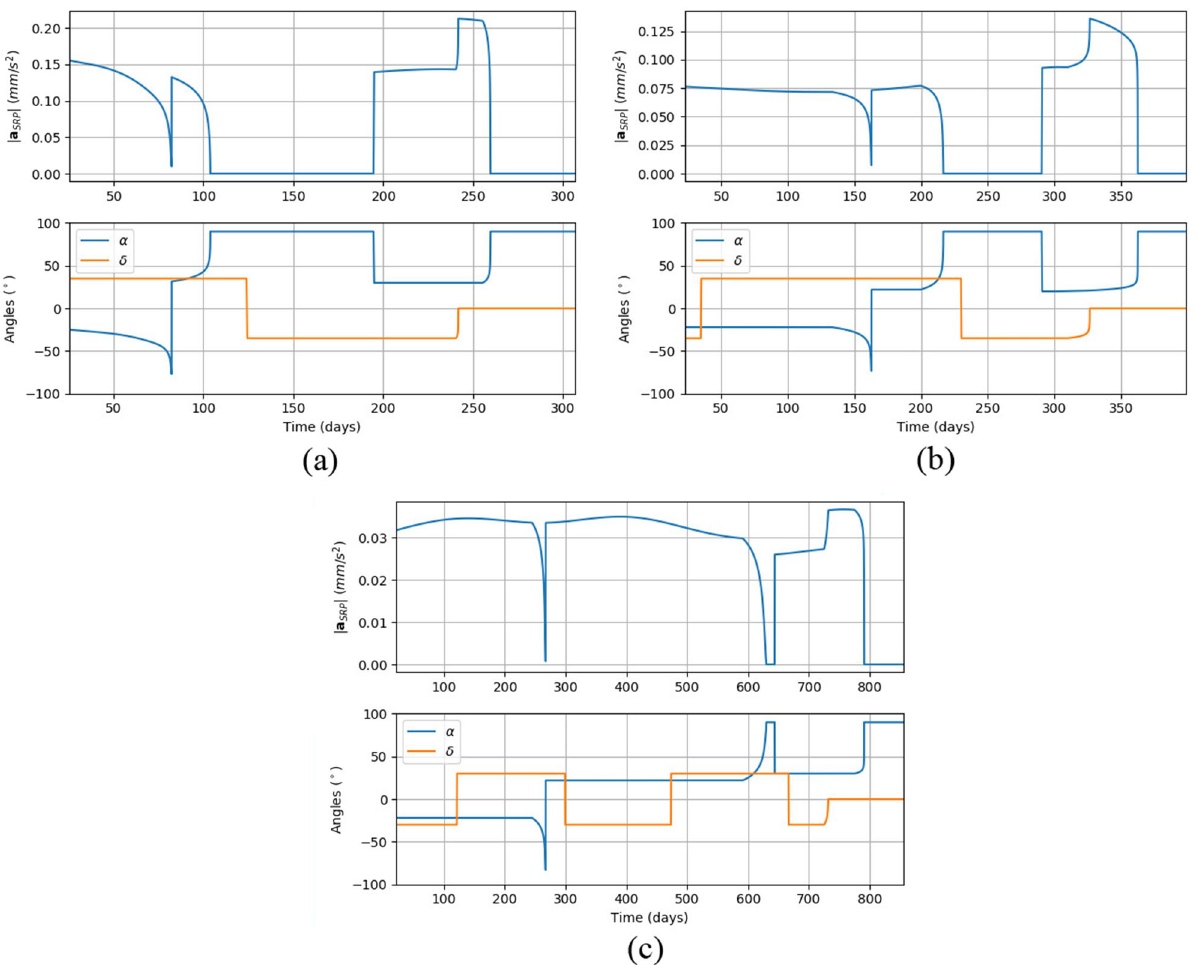
Figure 15. Sail steering angles and acceleration for missions with different sail loadings ( a ) σ = 30.6 g / m . ( b ) σ = 61.2 g / m 2 . ( c ) σ = 164.7 g / m 2